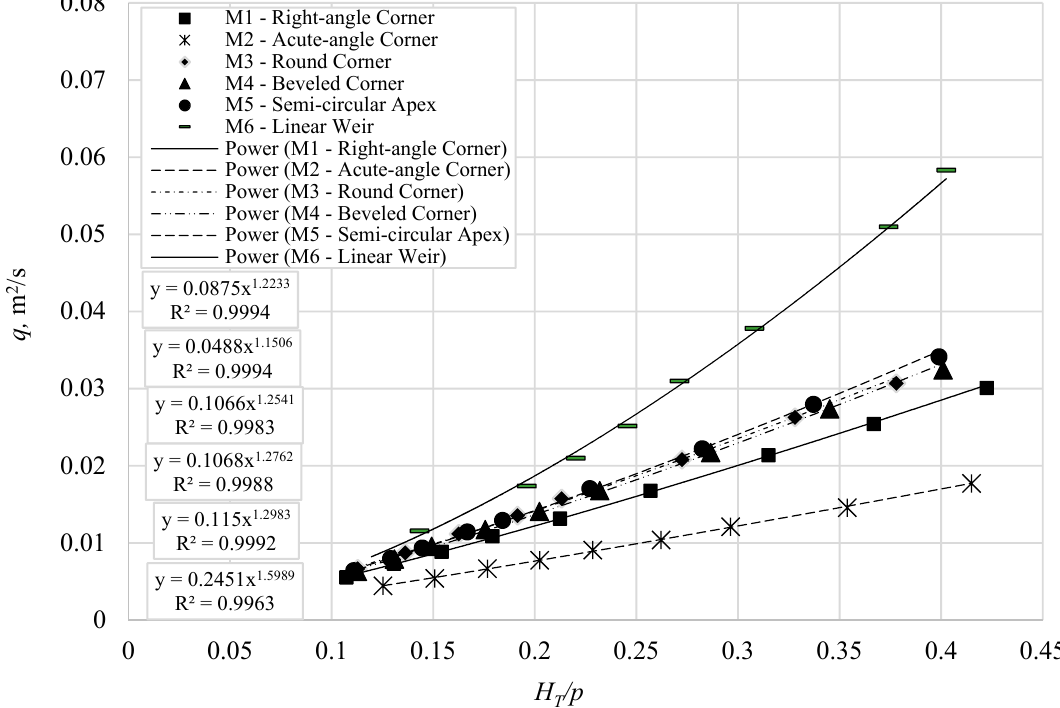
Figure 5. Variation of discharge capacity ( q ) versus H T / P for all physical